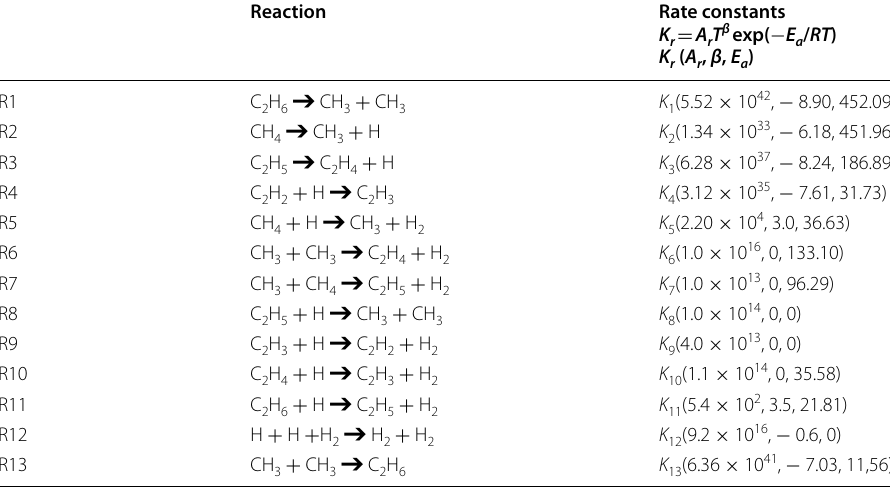
Table 2 Gas-phase reaction mechanism and corresponding rate constants